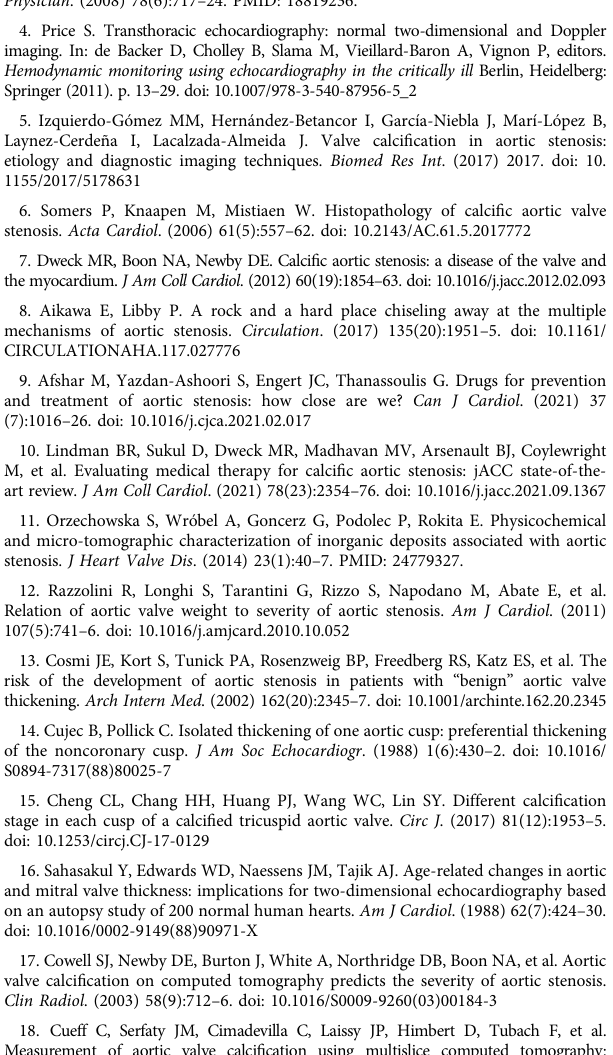
SUPPLEMENTARY FIGURE 1 Partial volume effect (PVE) correction for each density group. A – B: ortho-slices of sample N1.1 showing the classi fi cation of calci fi cation into low, moderate and high-density before (A) and after (B) the PVE correction. C: absolute volume of each density group within the calci fi cation for every cusp. Two bars are given for each cusp, before PVE correction (left) and after PVE correction (right).